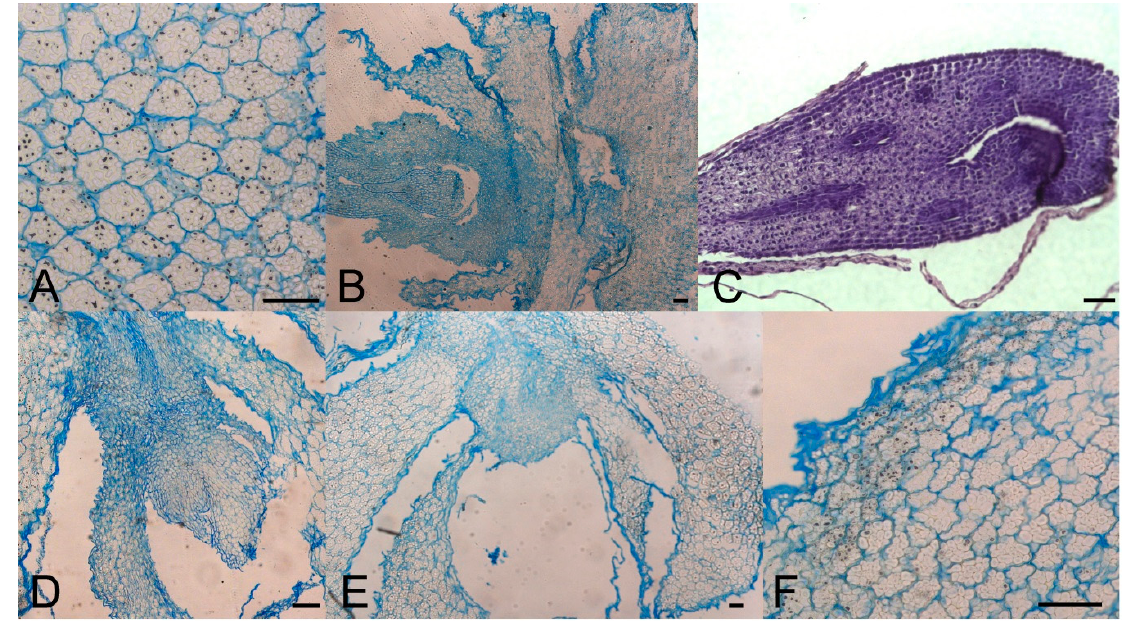
Figure 3. Morpho-anatomical study of F. meleagris bulbs sprouting after 5 weeks of culture with GA 3 and GA inhibitors (10 μ M). ( A ) Control bulbs cultured at 24 °C. ( B – D ) Bulbs cultured at 24 °C on medium with ancymidol ( B ), paclobutrazol ( C ) and GA 3 ( D ). ( E , F ) Bulbs cultured at 7 °C on medium with GA 3 . Scale bars = 100 μ m.